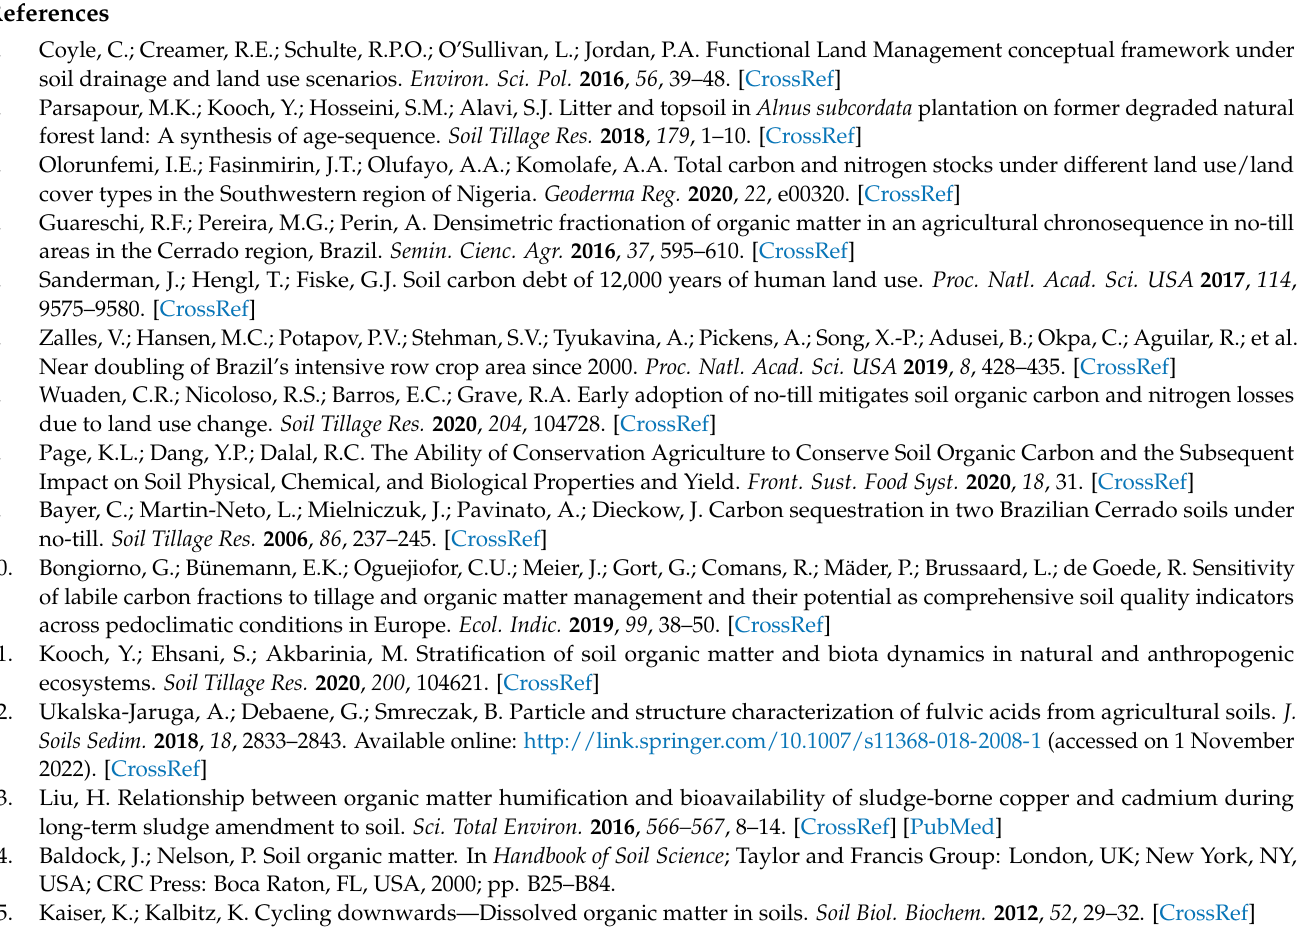
sample; Table S1: Historic of the crop systems applied in each area; Table S2: chemical properties (0-0.10 m depth) of the